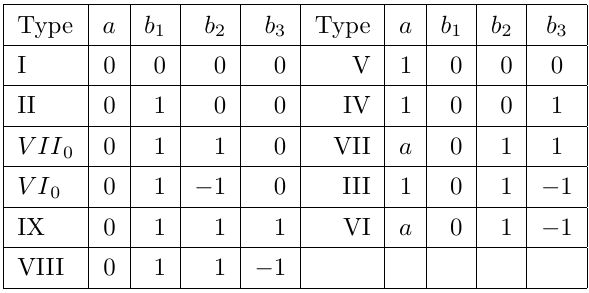
Table 1 . The Bianchi classi(cid:12)cation of three-dimensional real Lie